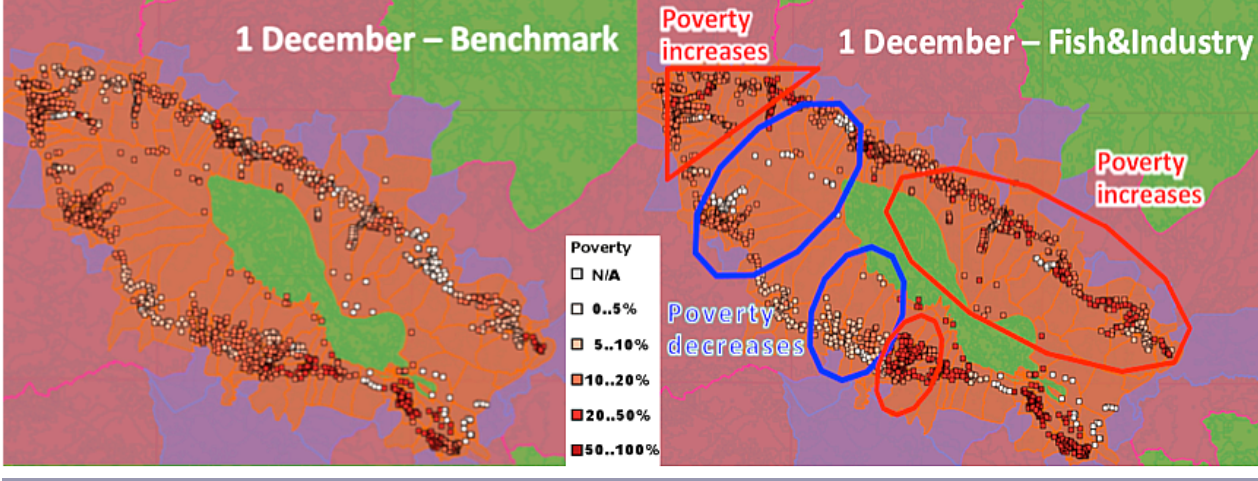
Fig. 5 . Poverty maps for the Tonle Sap for a representative benchmark (left) and scenario (right) run emerging from the Mersim model. Village locations are marked with increasing levels of red indicating higher levels of poverty.